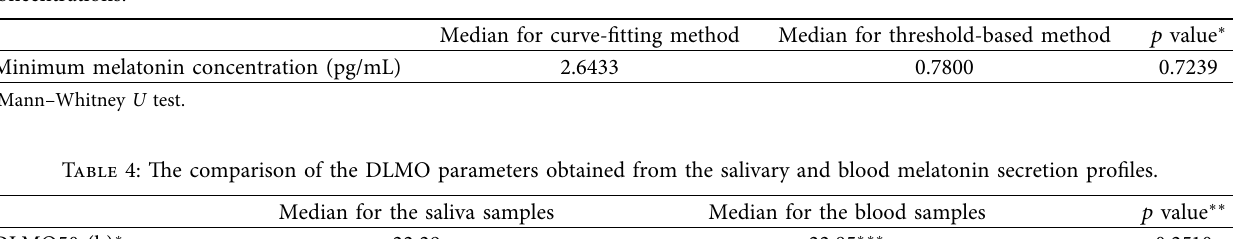
Table 3: Comparison of the curve-fitting and threshold-based (with a linear interpolation) methods—the minimum melatonin concentrations.